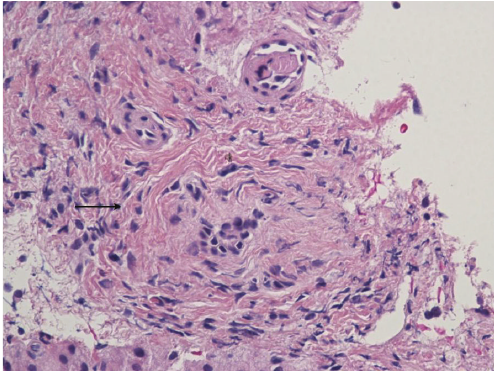
Figure 1: Liver biopsy portal tract and periductal fibrosis with narrowing of portal vein and it is